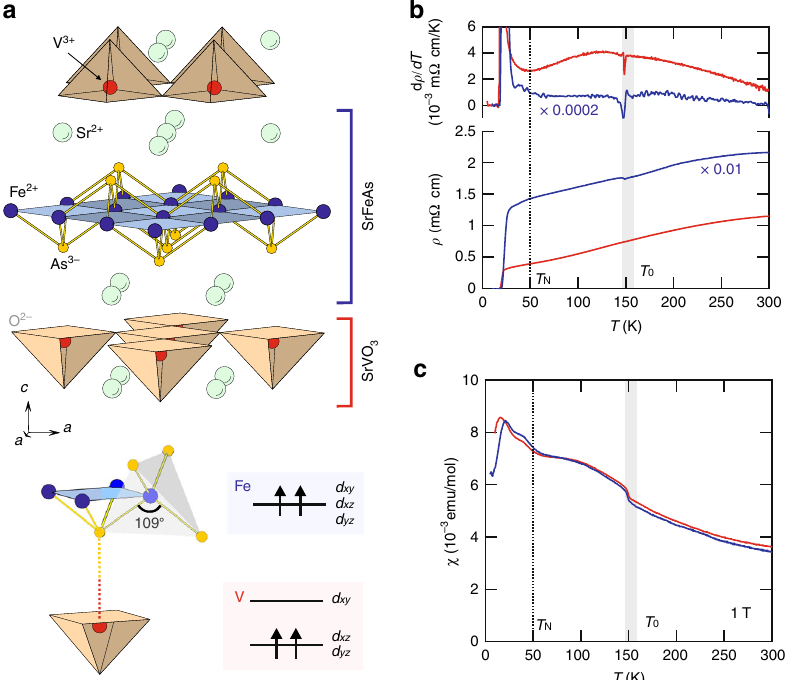
Fig. 1 Basic properties of Sr 2 VO 3 FeAs. a The crystal structure of Sr 2 VO 3 FeAs as a naturally assembled heterostructure of the [SrFeAs] +1 and [SrVO 3 ] − 1 layers. V ions form a network of corner-sharing tetrahedra, while FeAs layers consist of edge-sharing FeAs 4 tetrahedra as in other iron-based superconductors. The local structure of an FeAs 4 tetrahedron and a VO 3 pyramid is highlighted at the bottom. FeAs 4 tetrahedra provide a moderate cubic crystal fi eld splitting, much smaller than the band widths, while the VO 3 unit is missing one O entirely, and thus develops a strong Jahn – Teller splitting. The d d electrons occupy the d d S = 1 spin. The Fe and V planes are bridged by the As atoms, as xy orbital is pushed up, and the two V xz and yz states, forming an indicated by the dashed line. b The resistivity ρ ( T ) in the α b plane (red) and along the c axis (blue) shows a weak anomaly at T 0 ~ 155 K (blue highlighted region), which is more clear in their temperature derivatives (top panel). The large c -axis resistivity, which was scaled down by a factor of 100, is consistent with the quasi-2D nature of the material. c The magnetic susceptibility χ ( T ), taken at H = 1 T for H ⊥ c and H || c , shows clear anomalies at T 0 and also at T N ~ 45 K